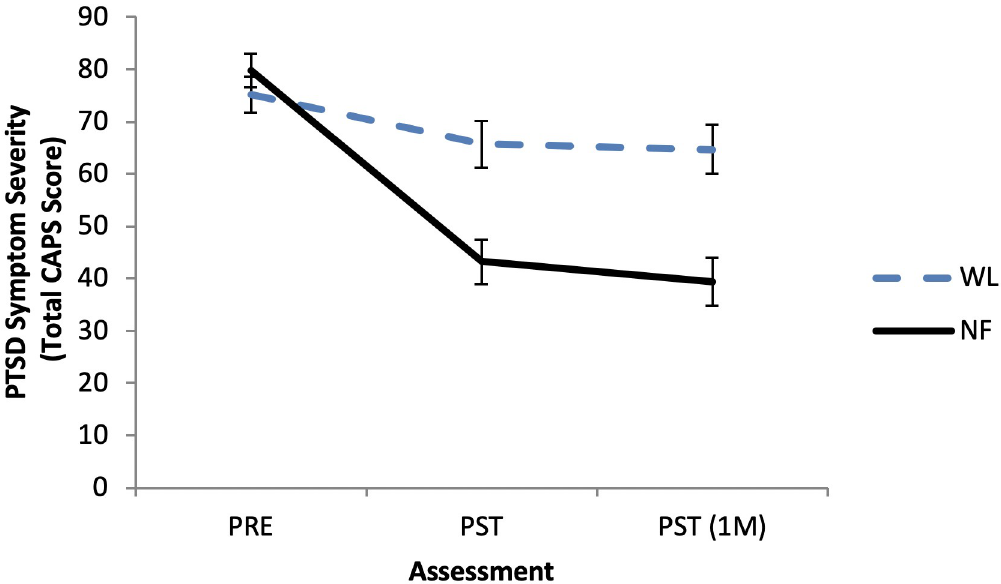
Fig 2. Change in PTSD symptom severity (Total CAPS score) as a function of treatment condition. WL = waitlist, NF = Neurofeedback. Standard Error bars included at each assessment.